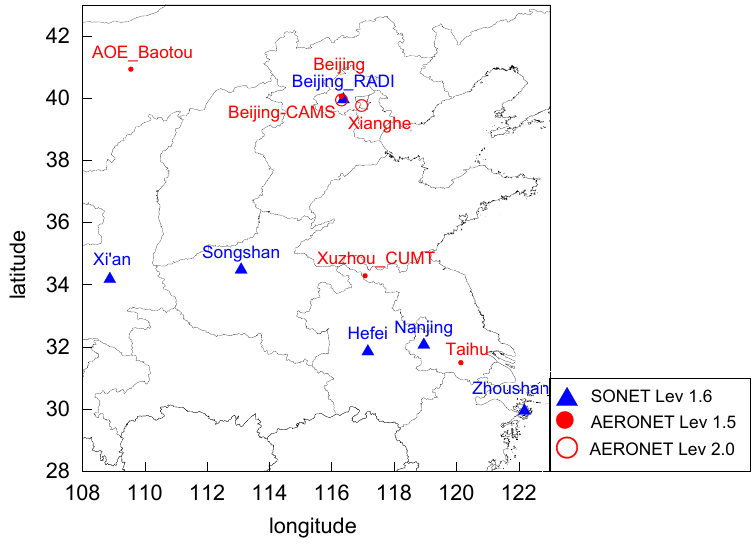
Figure 2. The study area and ground-based observation locations used in the study.